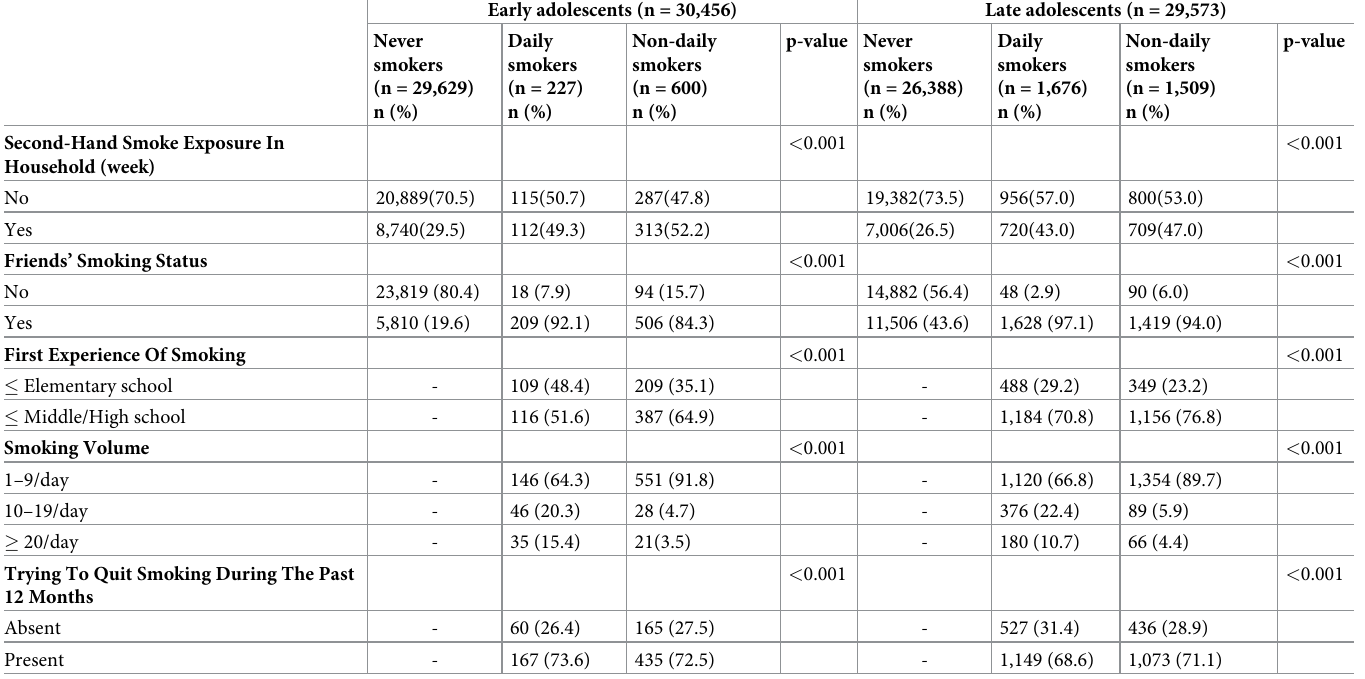
Table 2. Cigarette smoking-related factors based on smoking patterns (KYRBS, 2016, Korean adolescents aged 12–18 years).